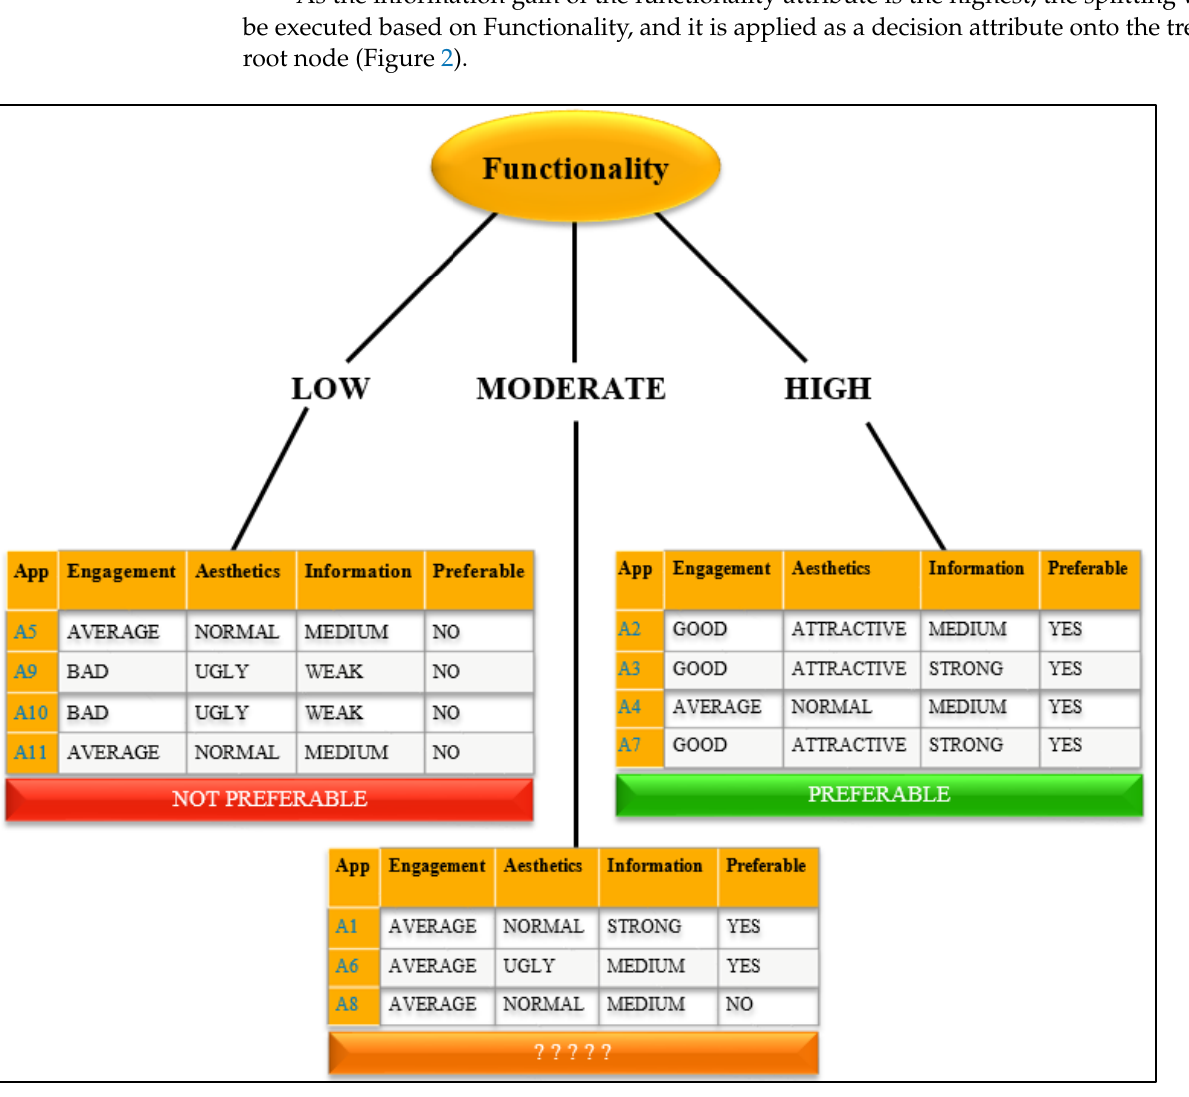
Figure 2. Root node of the ID3 decision tree.